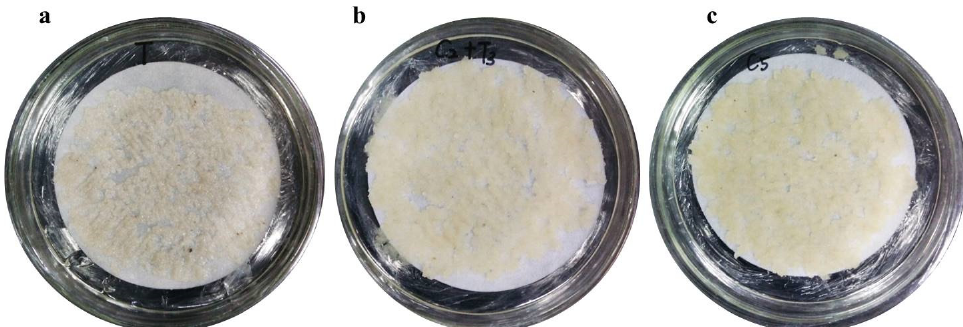
Figure 1. The recovery of embryogenic cell co-cultured with Agrobacterium with different combina- tions of Timentin and cefotaxime. ( a ) 300 mg/L Timentin, ( b ) 300 mg/L Timentin and 200 mg/L cefotaxime, ( c ) 500 mg/L cefotaxime. It was conducive to the recovery of embryonic cells on medium supplemented with 500 mg/L